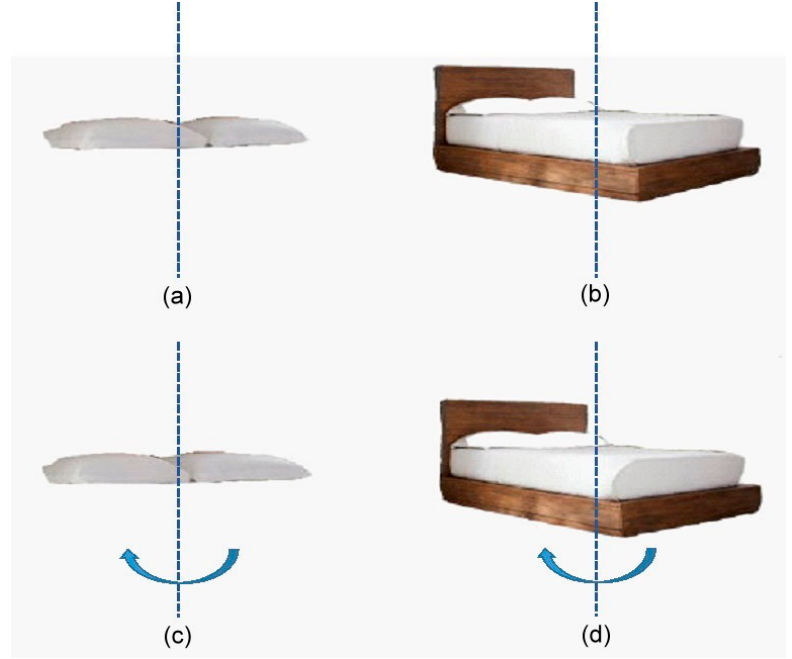
Figure 5. Results of rotating objects: ( a ) The pillows; ( b ) bed; ( c ) rotated pillows; and ( d ) rotated bed.